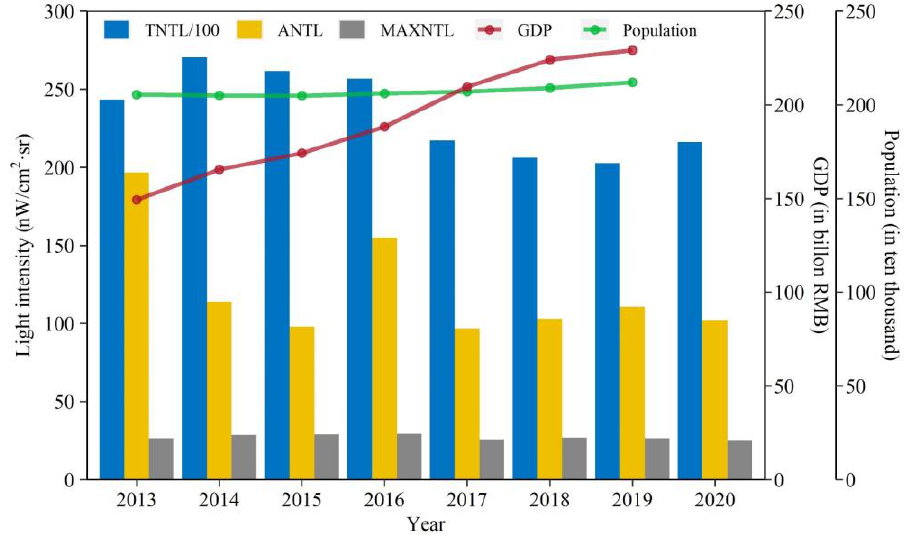
Figure 7. Changes in light intensity and GDP and population in Lanzhou from 2013 to 2019.